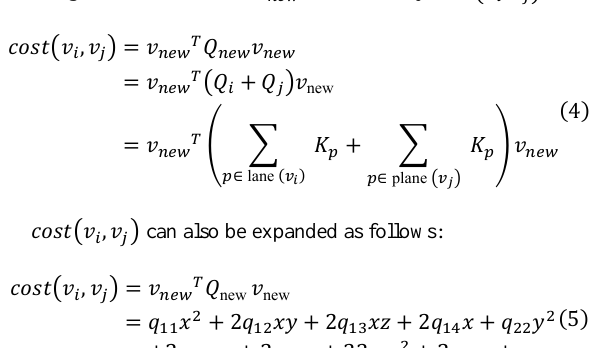
Figure 2 . Calculation of texture features: (a) original texture map (b) grayscale image (c) texture feature Map The 3D mesh is inverse mapped to the computed texture feature images to obtain the texture information values at the corresponding pixel in each image. In this paper, we calculate the arithmetic mean of the texture information values of multiple texture feature images to obtain the texture feature information values 𝑣𝑒𝑟𝑡𝑒𝑥 𝑡𝑒𝑥𝑡𝑢𝑟𝑒 at each